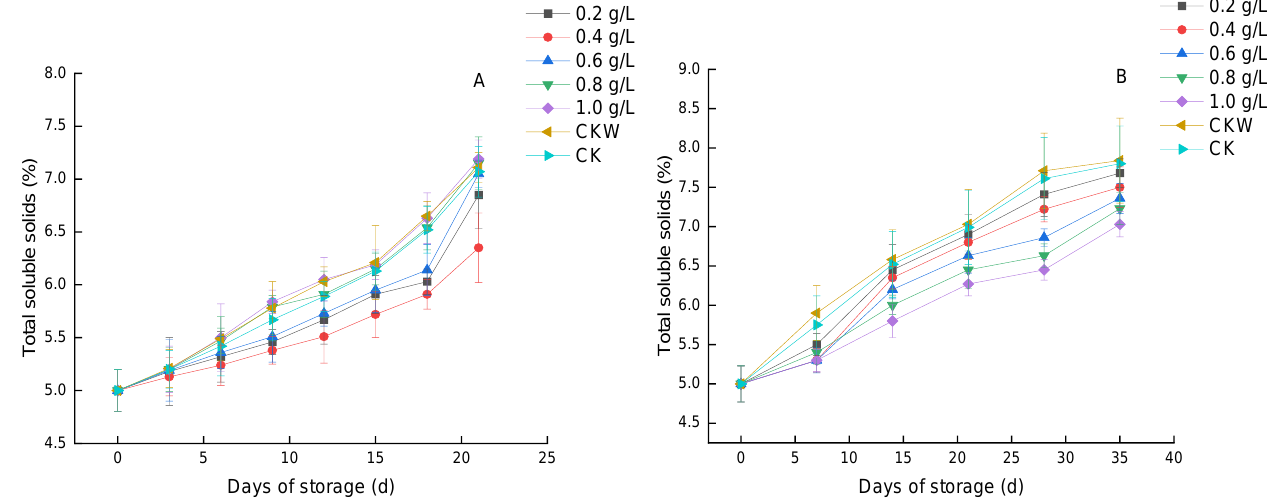
Figure 9. Effects of different Lycium barbarum leaf extract concentrations on the TSS content of cherry tomatoes at 20 °C ( A ) and 5 °C ( B ).